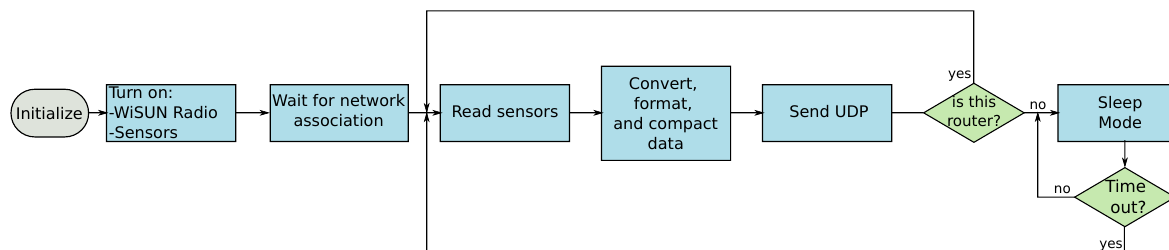
Figure 11. A generic flow chart for leaf and router